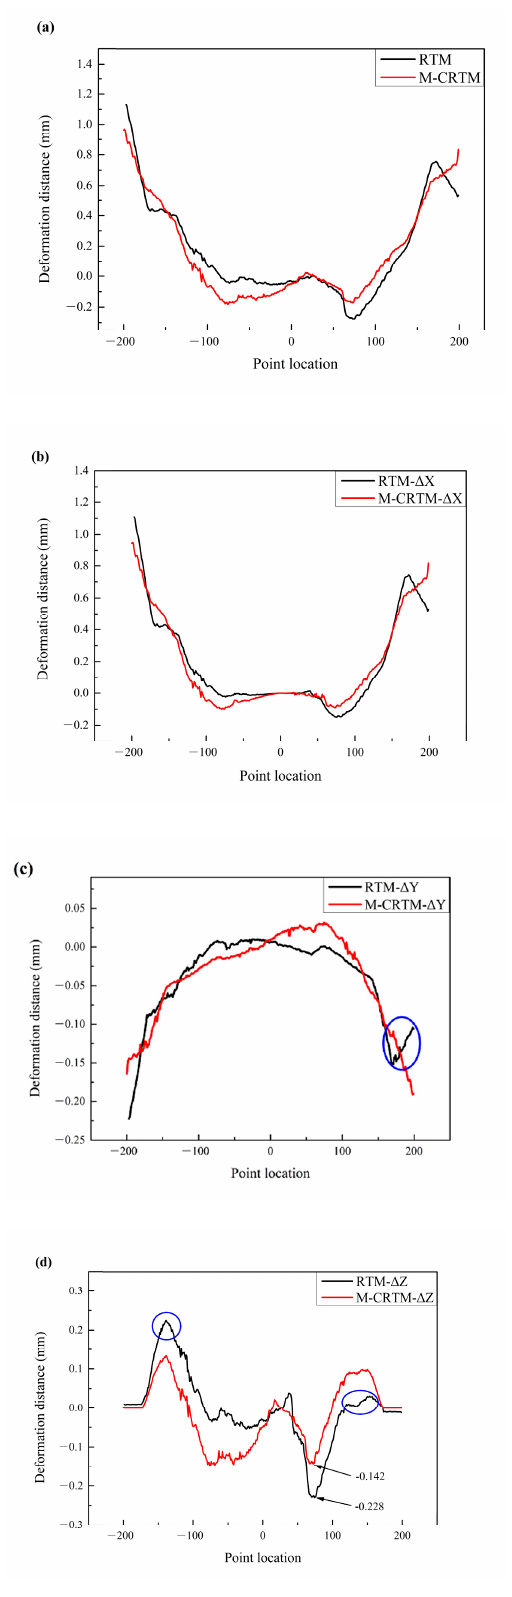
Figure 11. Deformation distance analysis of Section 2. ( a ) The overall deformation distance of Section 2; ( b ) deformation distance of Section 2 in the X direction; ( c ) deformation distance of Section 2 in the Y direction; ( d ) deformation distance of Section 2 in the Z direction.